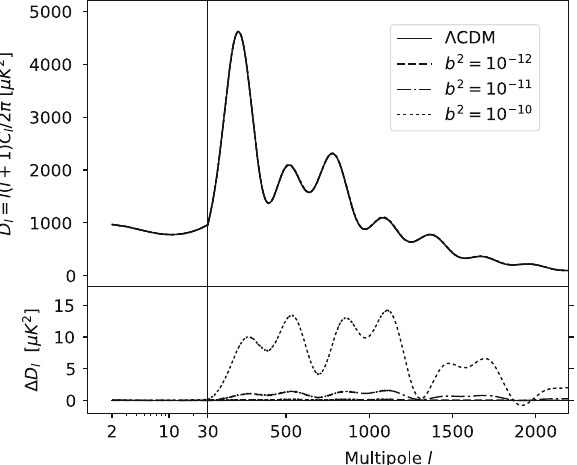
Fig. 4 CMB temperature power spectrum for several values of b . Plots for b 2 = 10 − 10 , 10 − 11 and 10 − 12 are shown in top panel. In bottom panel it is shown the difference D l defined in Eq. (19). Note that for l (cid:3) 30 all curves are indistinguishable and differences appear after l ∼ 30. For velocities of the order of v (cid:3) 3 km/s, differences with CDM case is ∼ 0 , 015% at